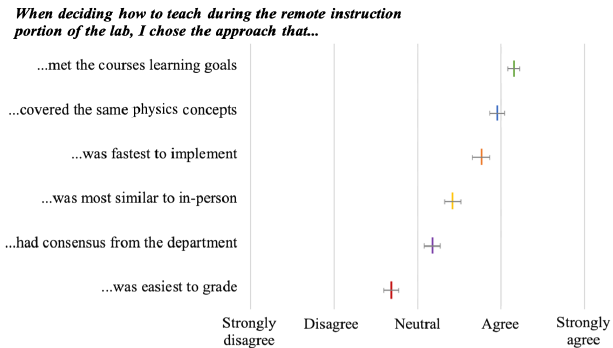
FIG. 3. Instructors were asked to “ Rank how much you agree with the following statements. ” We show the mean response from 121 survey responses and the uncertainty, which represents one standard error of the mean. We calculated the mean by assigning a response of strongly disagree ¼ 0 , disagree ¼ 1 , and neutral ¼ 2 , agree ¼ 3 , and strongly agree ¼ 4 .